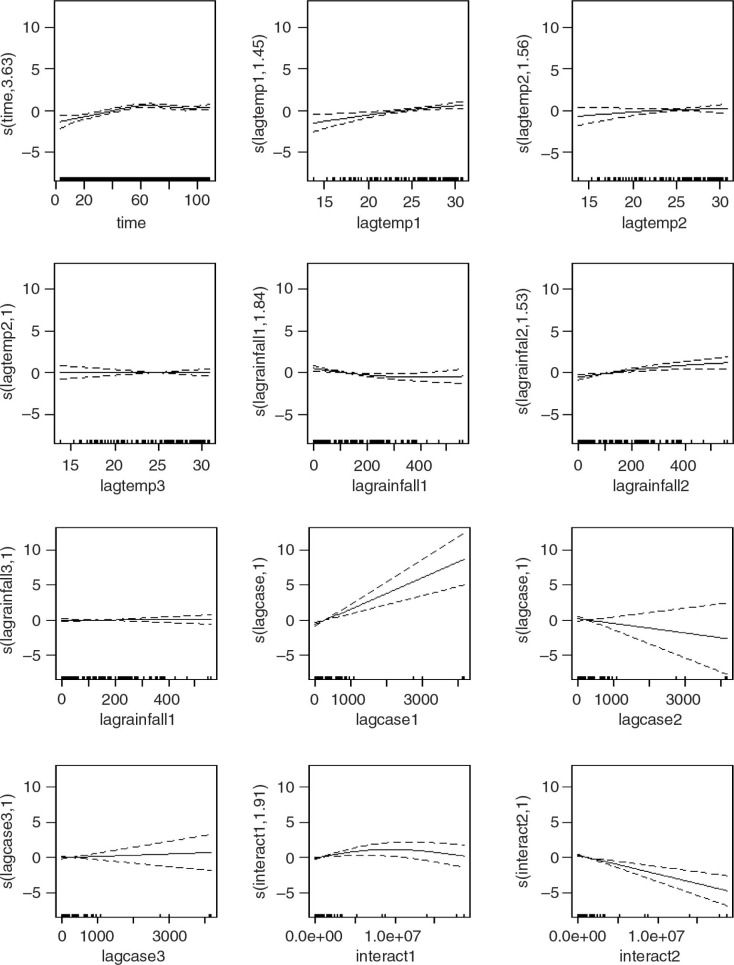
Graphs of model-5.